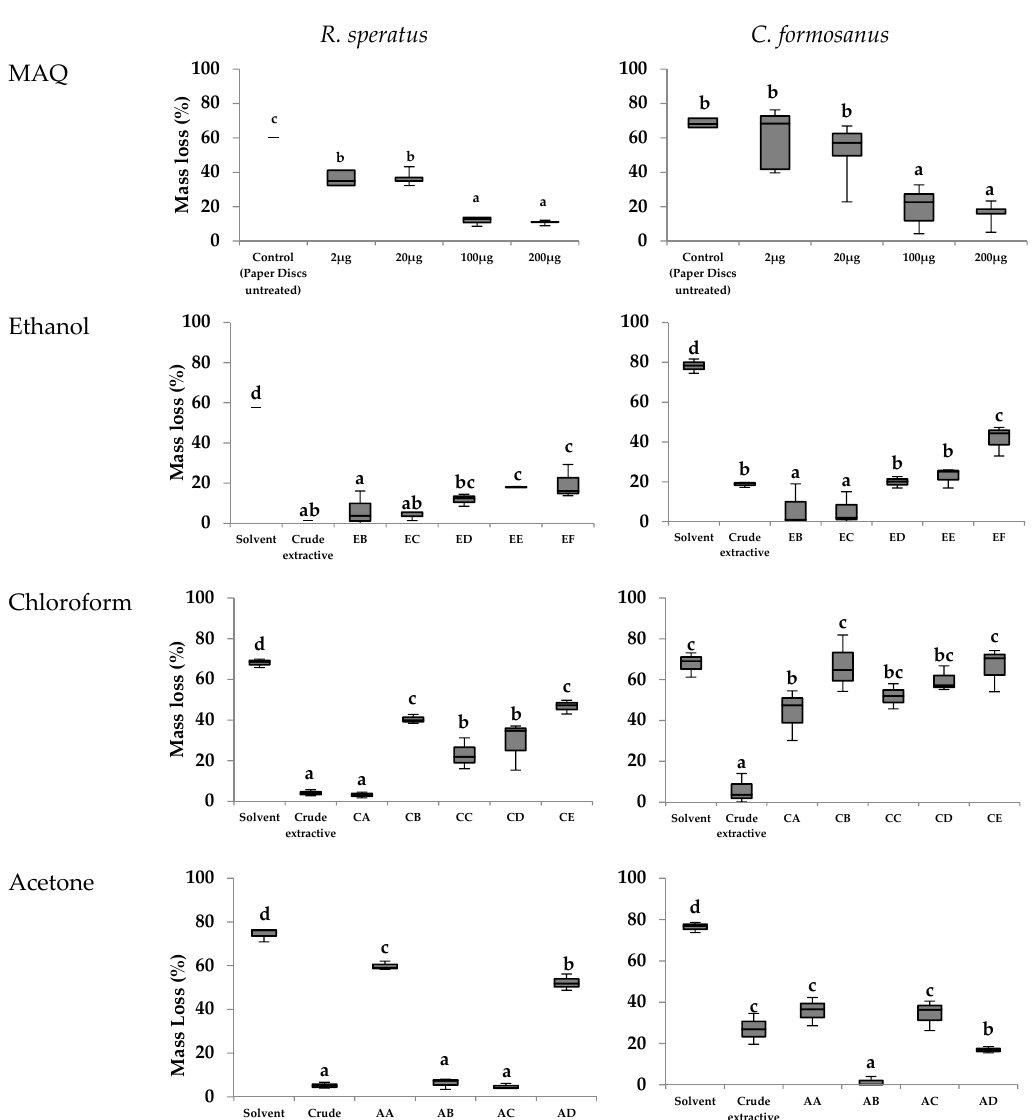
0.182, respectively; p values for C. formosanus : 0.241, 0.327, 0.160, and 0.674, respectively).